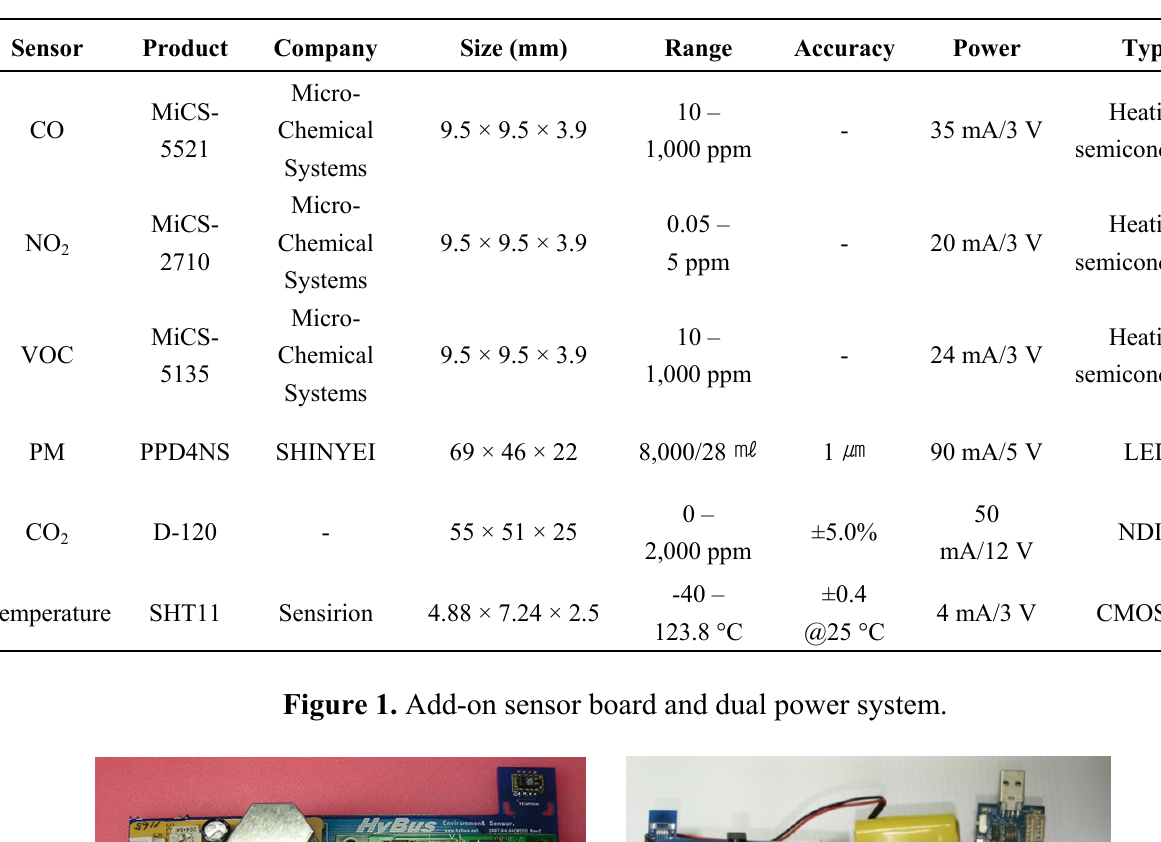
Table 2. Sensor specifications of the prototype.